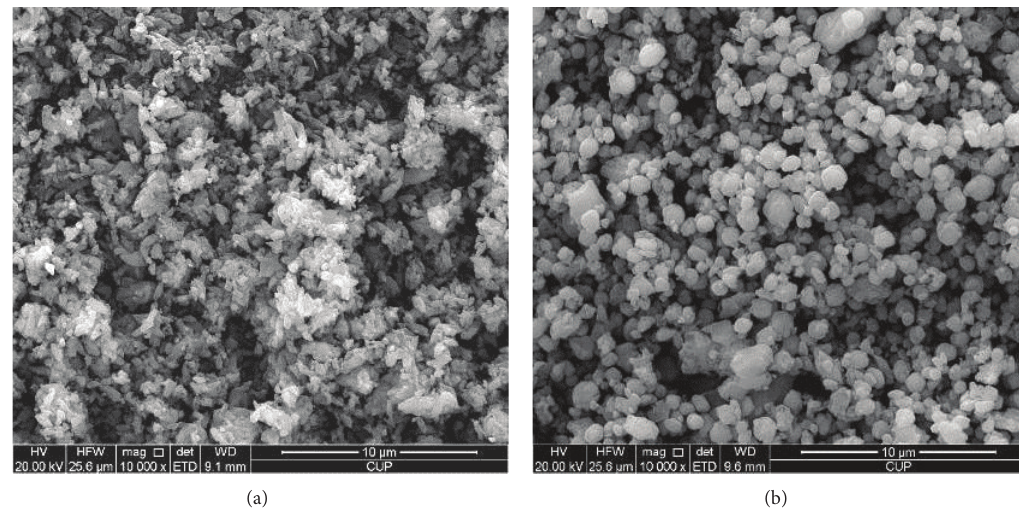
Figure 7: SEM of the catalyst particle ((a) is the outlet particle and (b) is the inlet particle).